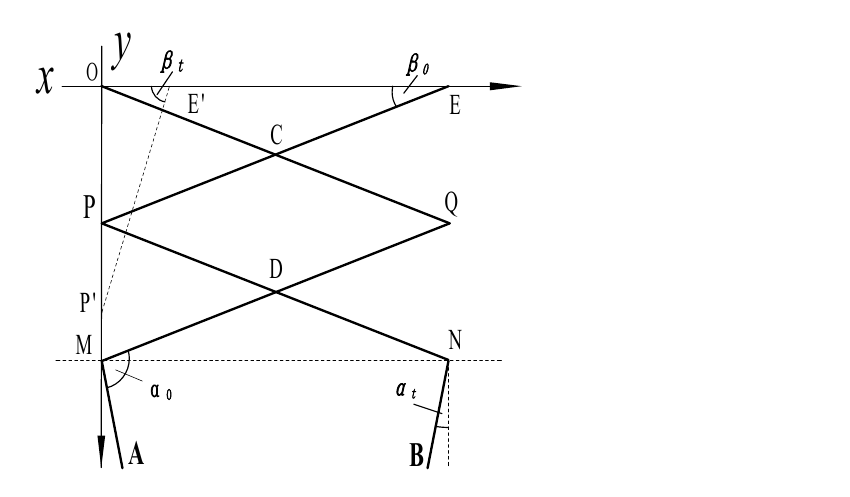
Figure 5. Structure diagram of the pick-up device. OQ, EP, PN, and QM are stretchable slices, MA and NB are needles, β is the angle between stretchable slice and horizontal plane, α 0 is the initial installation angle of seedling needles and stretchable slices, and α is the angle between the seedling needle and the horizontal plane.